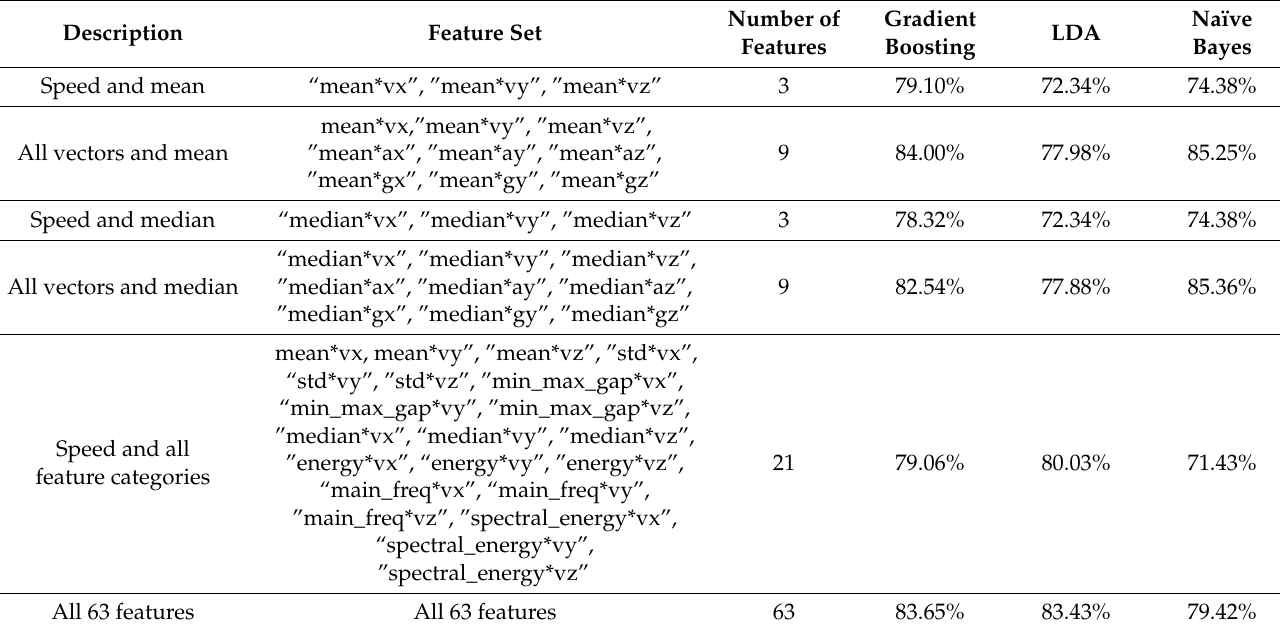
Table 10. Feature selection performance with benchmark